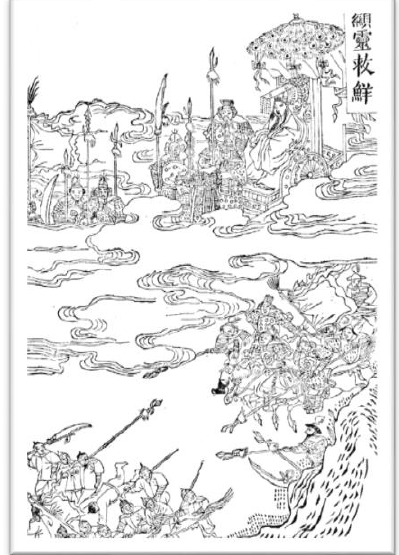
Figure 6. Manifestation of Thearch Kwan in Chosŏn ( Records of Sacred Achievements in the East of Sea [HD] 1876, vol. 1, 1a).